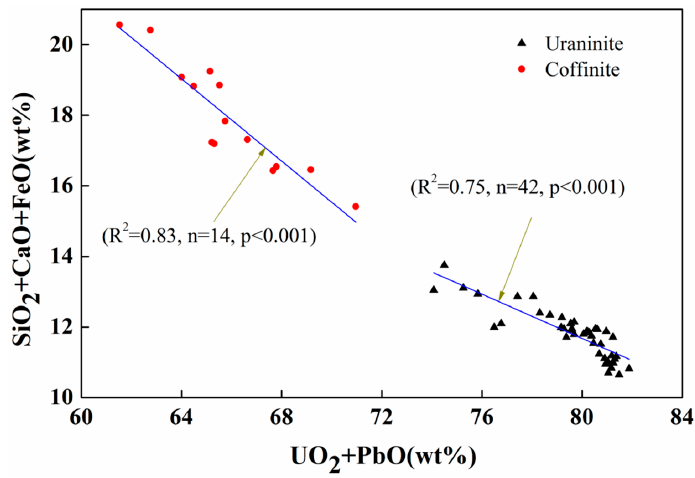
Figure 13. Binary diagrams of UO 2 + PbO vs. SiO 2 + CaO + FeO.